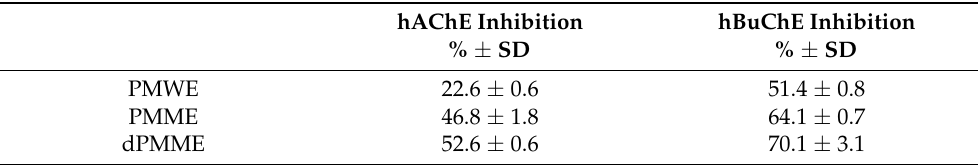
Table 1. Anticholinesterase activity of PM extracts at 0.10